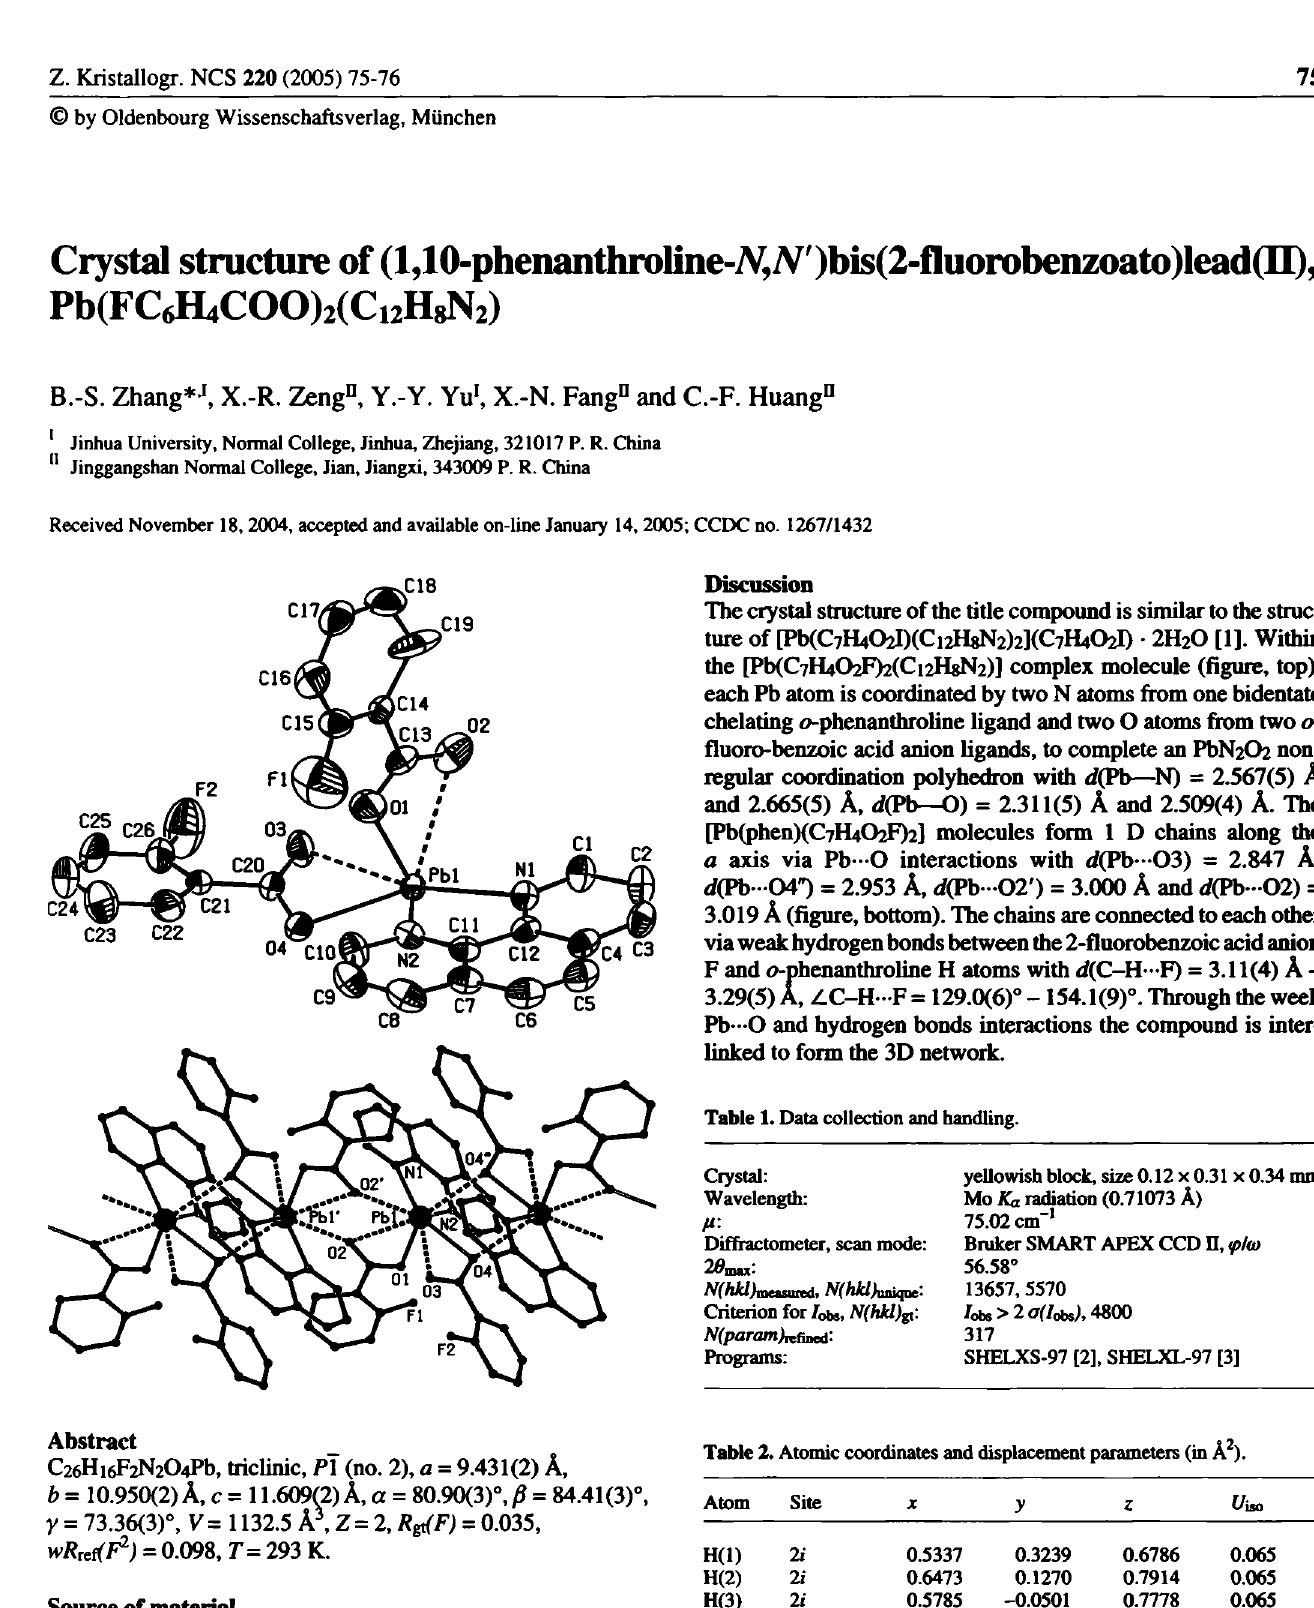
Table 2. Atomic coordinates and displacement parameters (in Ä 2